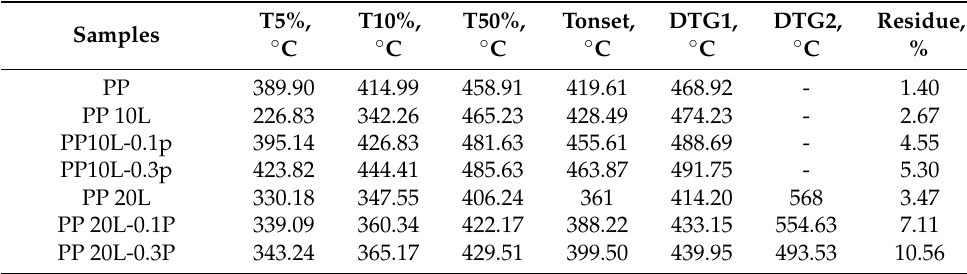
Table 3. Results of Thermal Gravity analysis (TGA) and Differential thermogravimetry (DTG) of polypropylene, polypropylene/lignin blends sponges and their modified forms with